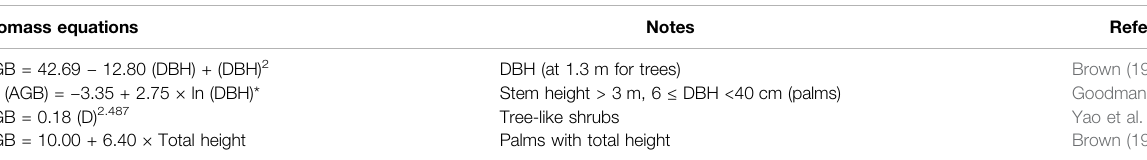
TABLE 3 | Speci fi ed biomass equations based on general allometric equations. Biomass equations